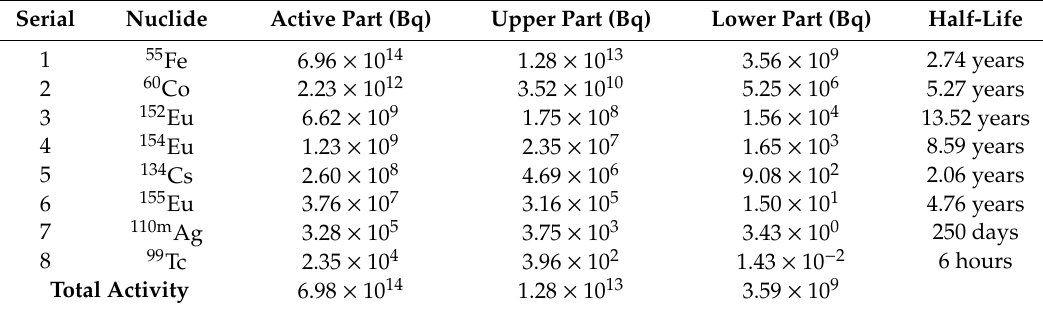
Table 1. Source terms in di ff erent parts of reactor pressure vessel.